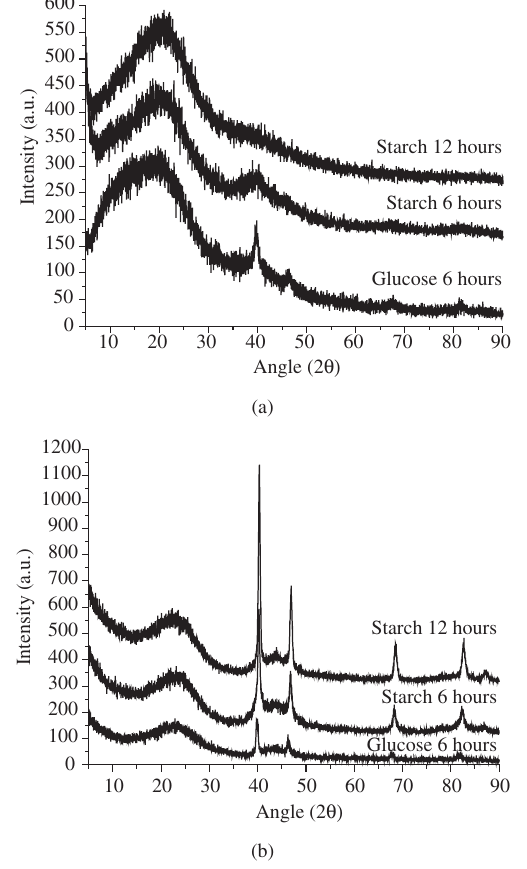
Figure 2. X ray diffractograms of PtRu/Carbon materials (a) as-synthesized and (b) after thermal